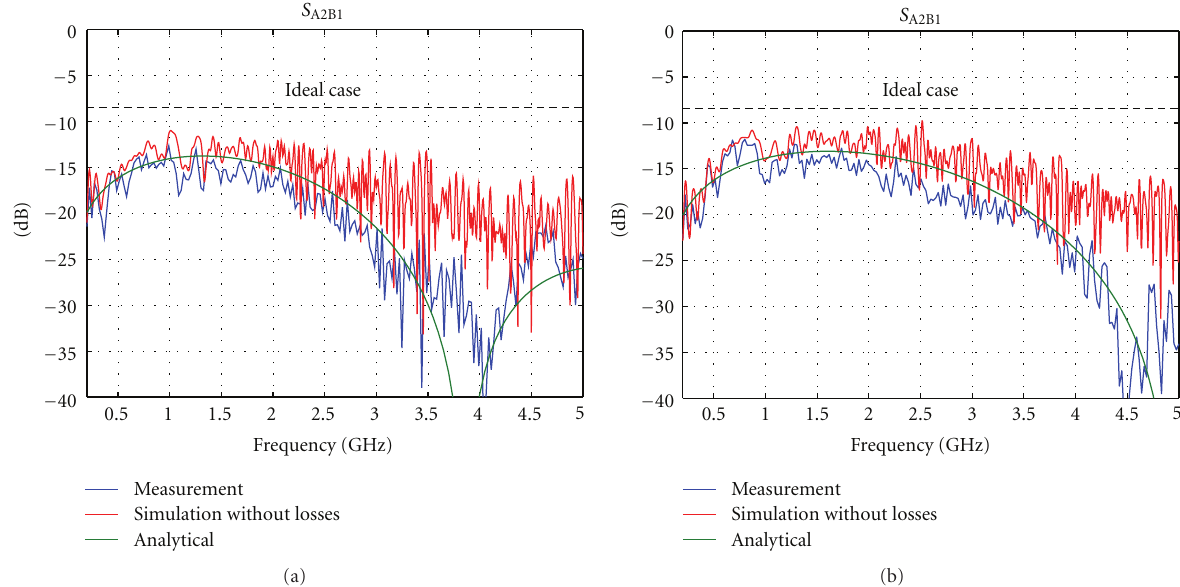
Figure 5: Comparison of transmission coe ffi cients: analytical model, simulation, and measurement.